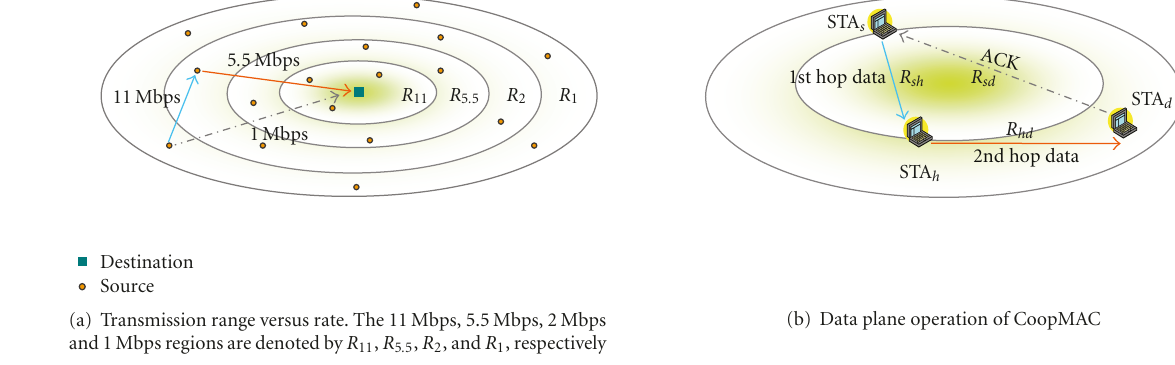
Figure 1: Cooperation at MAC layer.